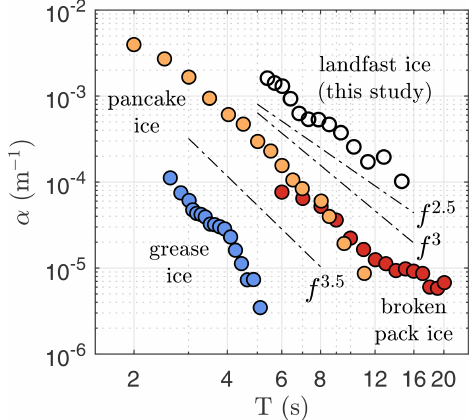
Figure 4. Comparison of experiment-averaged wave attenuation rates α for different types of sea ice (all field observations): grease ice (Kodaira et al., 2020), broken pack ice (Kohout and Williams, 2013), pancake ice (Thomson et al., 2018) and landfast ice (this study). Mean attenuation values of the experiments of Kohout and Williams (2013) and Thomson et al. (2018) are taken from Liu et al. (2020). Observations of α in landfast ice fall between f 2 . 5 and f 3